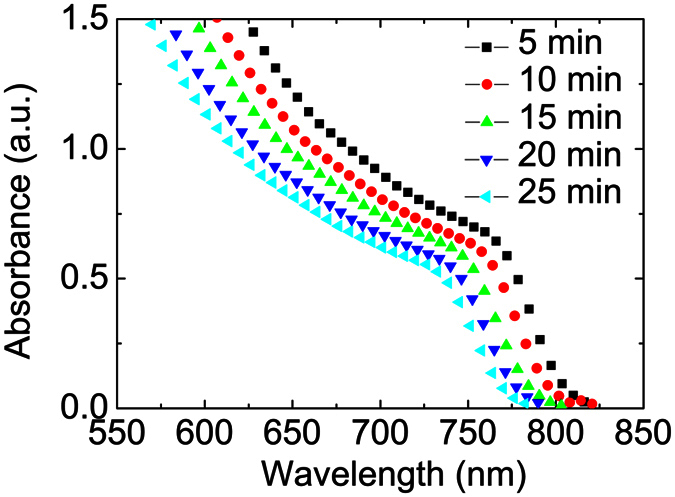
Absorption spectra of MAxFA1−xPbI3 films with 10 sccm H2 flow rates at different growth time from 5 to 25 min.